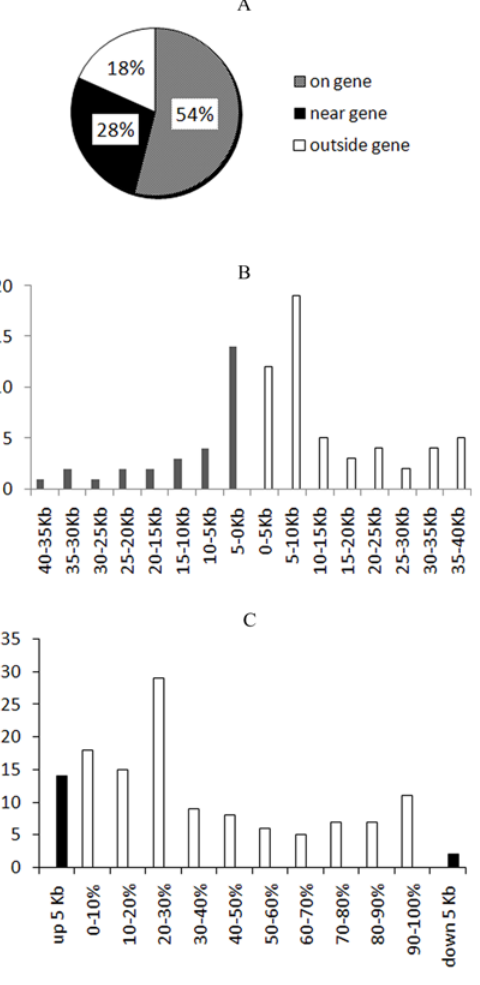
Figure 1. Figure 1A. Pie chart of retroviral integration sites (RISs) from 213 unique sites. Percents are shown; near gene is defined as 100 Kb up- or downstream of transcription units. Figure 1B. Genomic distribution of RISs with respect to the distance from transcription start sites (TSSs). The frequency (%) of RISs is plotted versus 40 kilobases (Kb) upstream (gray bars) or downstream (white bars) of TSSs. Figure 1C. RISs in and near gene coding regions. RIS locations inside genes are expressed as the percentage of the overall length of each individual vector targeted gene. Upstream 5 kilobases (up 5 Kb) or downstream 5 Kb (down 5 Kb) are denoted in black bars. All other RISs are located within 5 Kb of TSS.